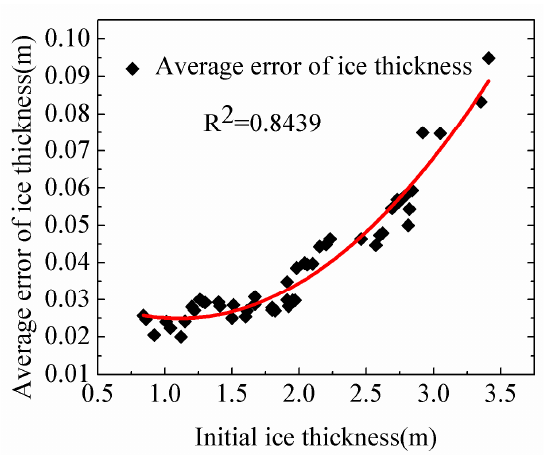
Figure 12. The average estimation error of sea ice thickness against the initial sea ice thickness. The red line is the fitted curve line.